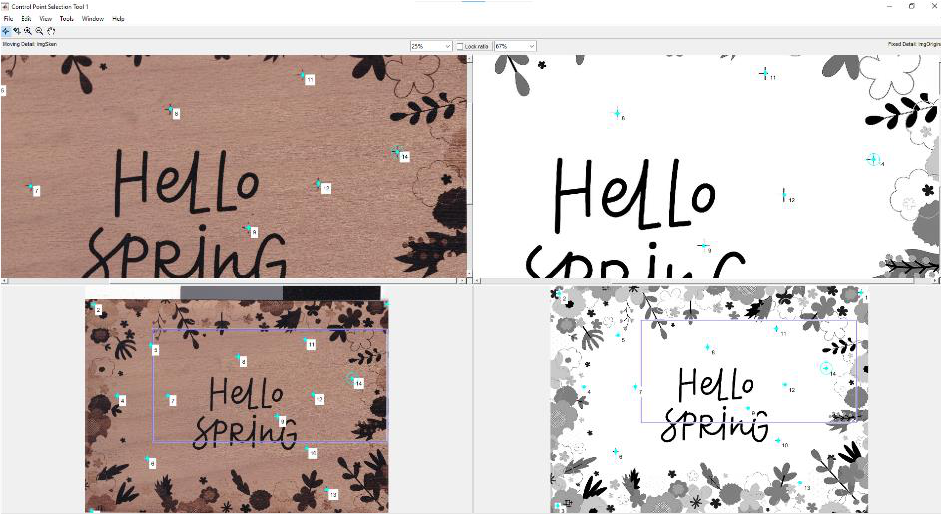
Figure 4. GUI of CPSP tool.